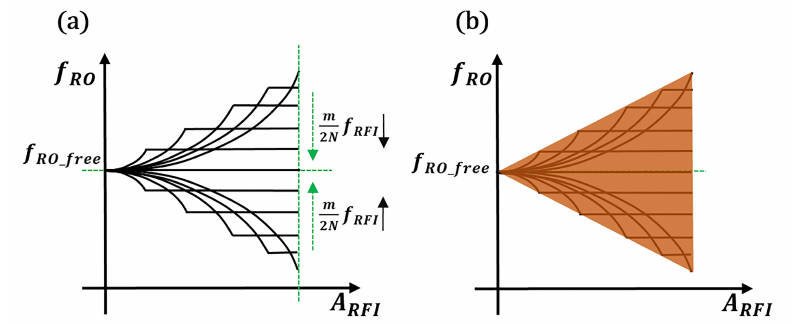
Figure 3. Derivation of the conical locking region. ( a ) Response curves under different f RFI ; ( b ) conical locking region.